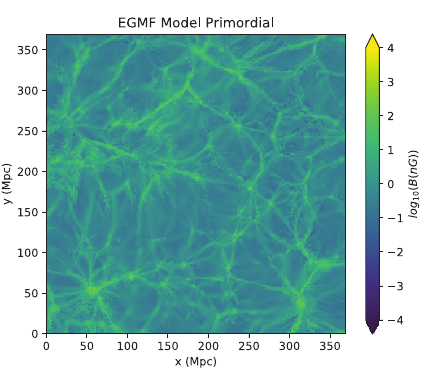
Figure 1. Mass density distribution in super-galactic coordinates at z = 0. The mass density n is normalized to the average density in the simulation volume (cid:6) n (cid:7) . The plot shows the super-galactic plane orthogonal to the Z -axis including the Milky Way at the centre.